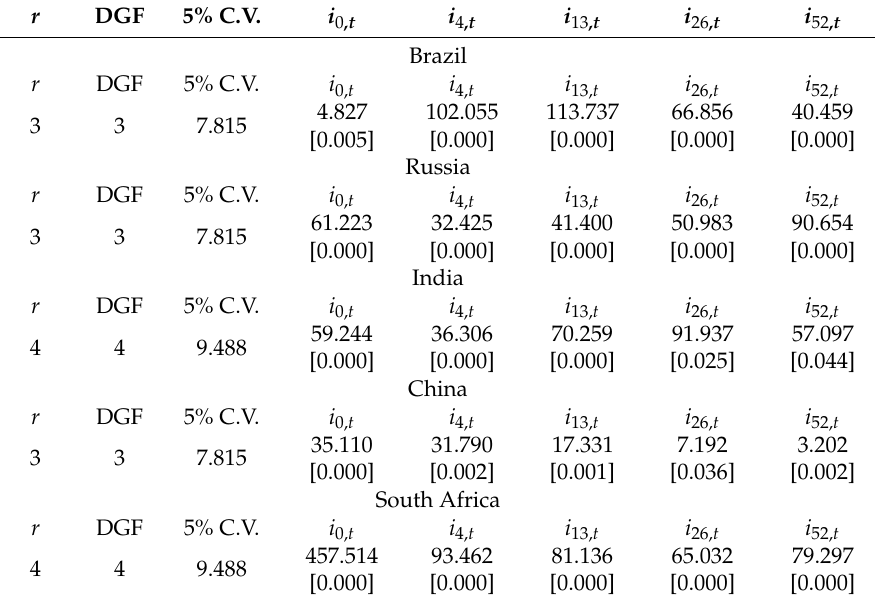
Table 1. Variable exclusion